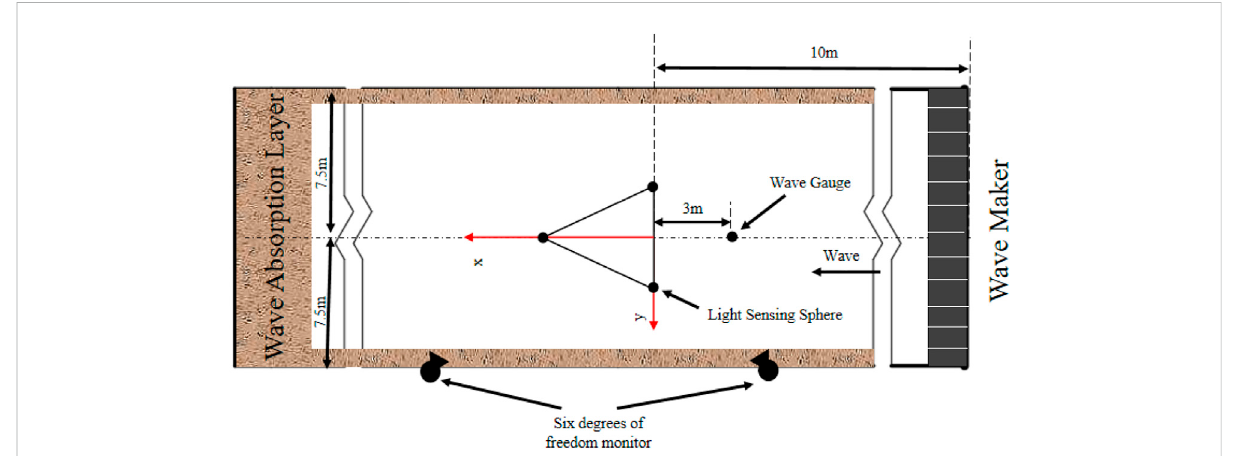
FIGURE 7 Layout diagram of fl oating offshore wind turbine with the wave direction of 0 ° .